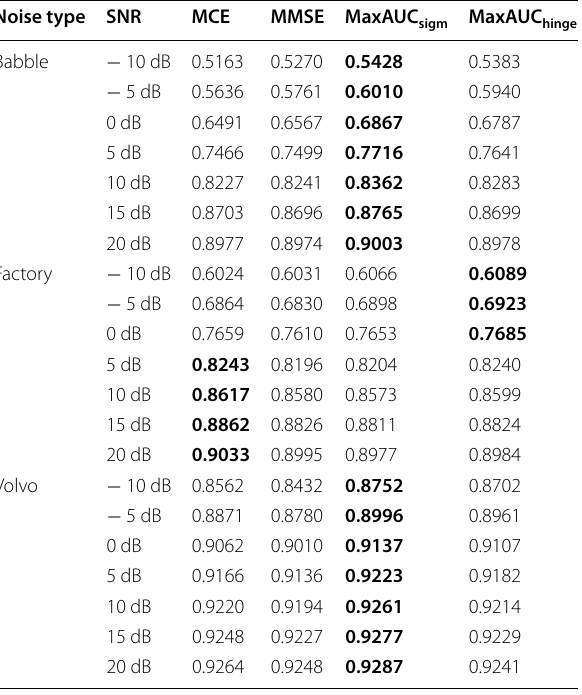
Table 4 AUC results of the comparison VADs with the BLSTM model and STFT acoustic feature on the Chinese Noisy‑THCHS‑30 test